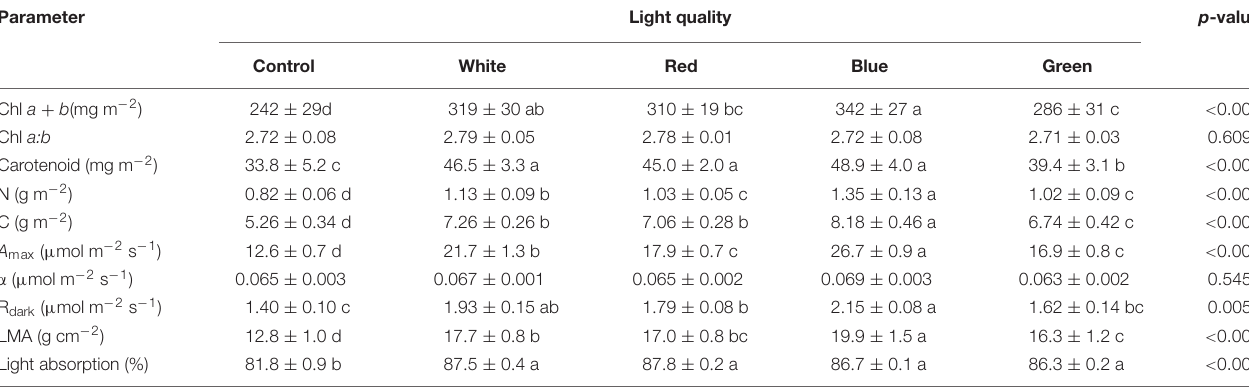
TABLE 3 | Leaf biochemical, photosynthetic, and morphological traits of cucumber plants grown under different supplemental light spectra. Parameter Light quality